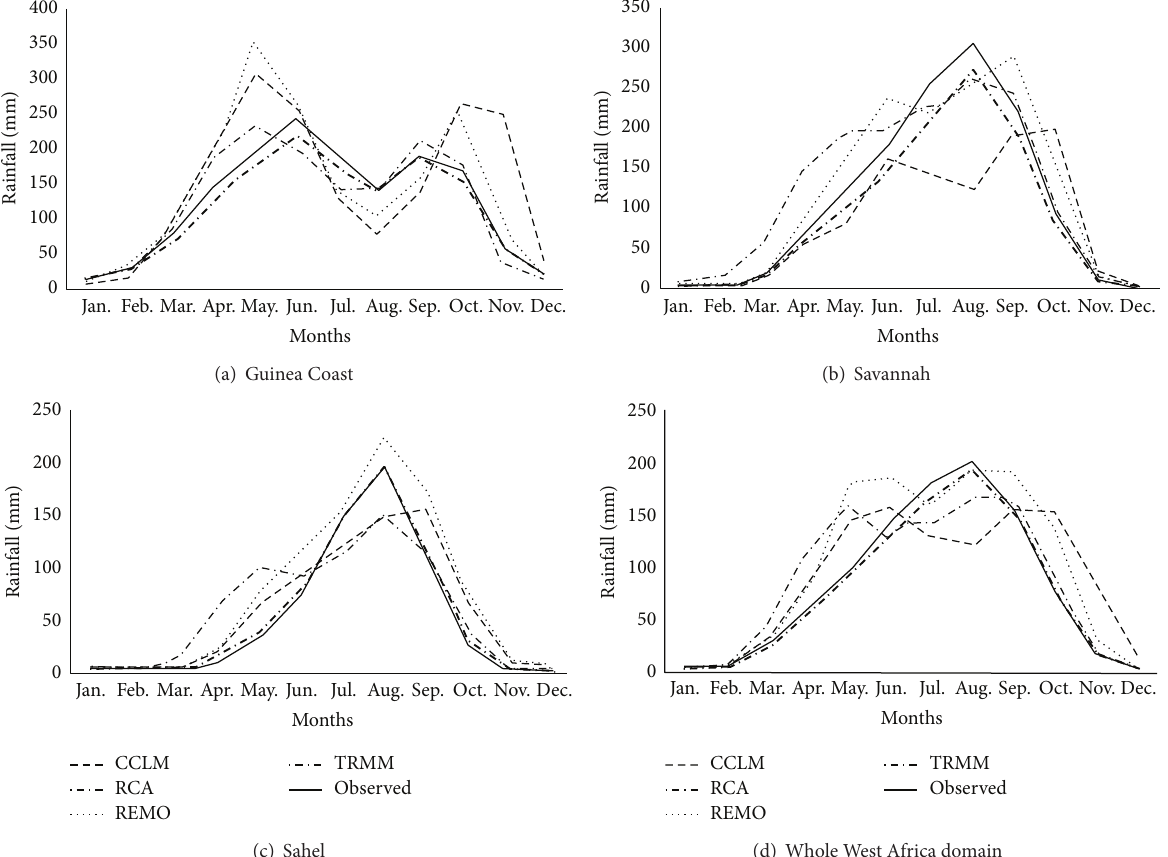
Figure 6: Inter-seasonal variation of mean monthly precipitation (mm) over (a) Guinea Coast, (b) Savannah, (c) Sahel, and (d) for the whole West Africa